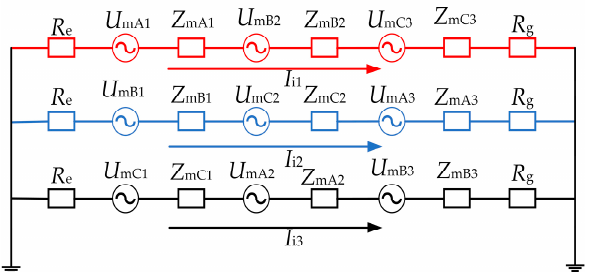
Figure 4. Equivalent induction circuit of metal sheath of cross-bonded cable.